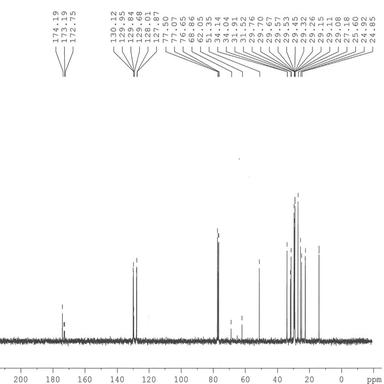
13C NMR Spectrum of Peelu Crop Methyl Esters Showing Various Absorption Peaks in Lab Sample.